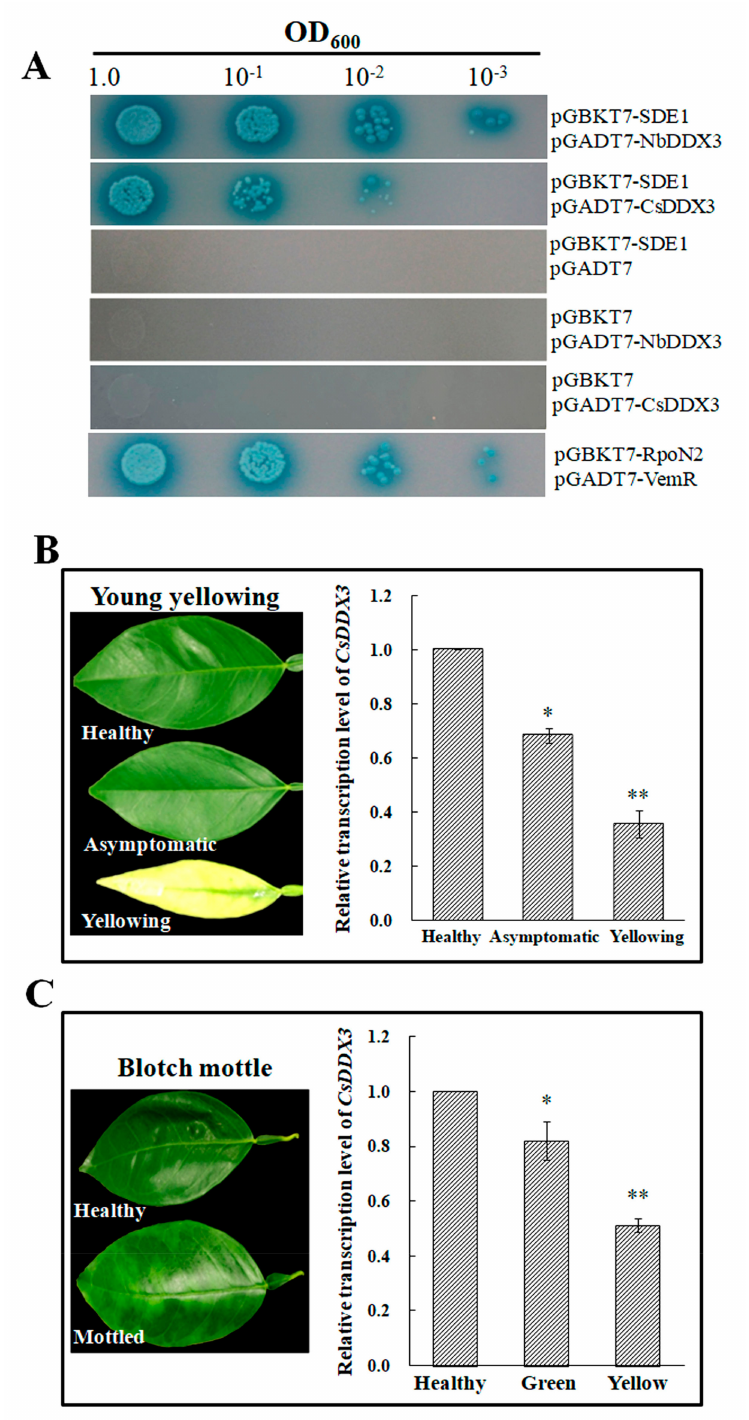
Figure 6. The association of CsDDX3 with SDE1 and yellowing HLB-infected citrus leaves. ( A ) Y2H showing interaction of CsDDX3 with SDE1. AH109 transformants were grown on SD / -Ade / -Leu / -Trp / -His media supplemented with 20 µ g / mL X- α - galactosidase. ( B , C ) Relative transcription level of CsDDX3 in young yellowing and mature blotch-mottled citrus leaves. The leaves show representative examined samples. The expression of CsCOX was used as an internal control. The expression level of CsDDX3 in healthy plants was set to “1”. The fold change in other samples was calculated by comparison with healthy leaves. Error bars indicate standard deviations, and asterisks denote statistical significance (* p < 0.05, ** p < 0.01, n = 3). All experiments were repeated three